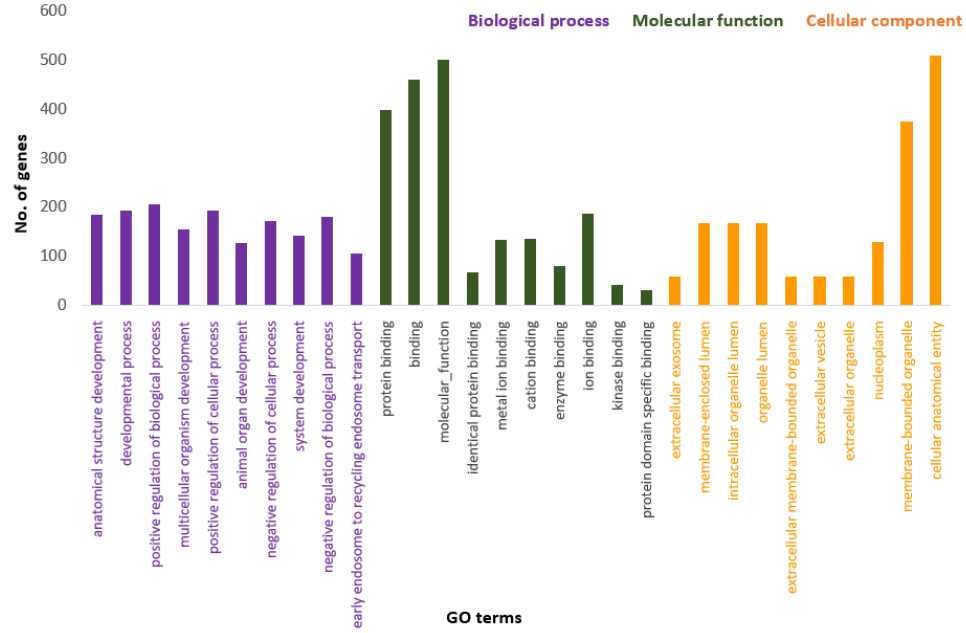
Figure 4. Top ten significant gene ontology terms (GO terms) enriched in overlapping selective signals of Fst and XP-EHH.